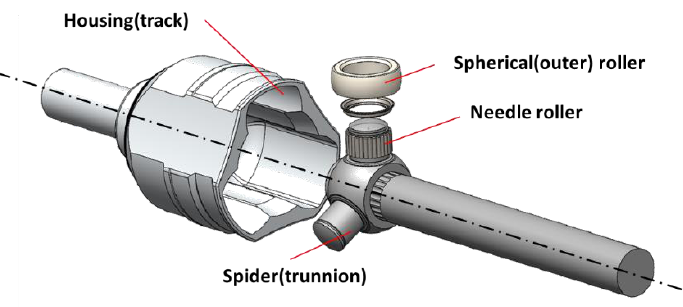
Figure 1. Exploded view of tripod-type constant velocity joint.